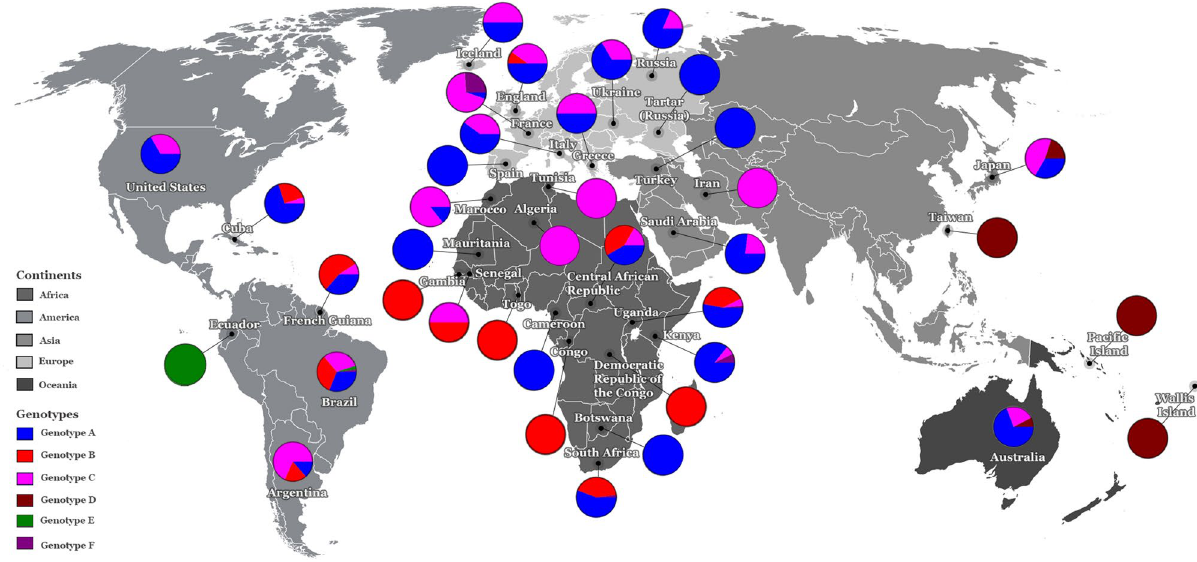
Figure 4. The HHV-8 genotypic diversity per country/origin. The pie charts indicate the proportion of occurrence of the different HHV-8 genotypes in the respective countries/origins. The genotypes and continents are indicated in the figure. Countries from the same region are shaded in the same colour on the world map. These distributions of HHV-8 genotypes were based on sequences analysed in this